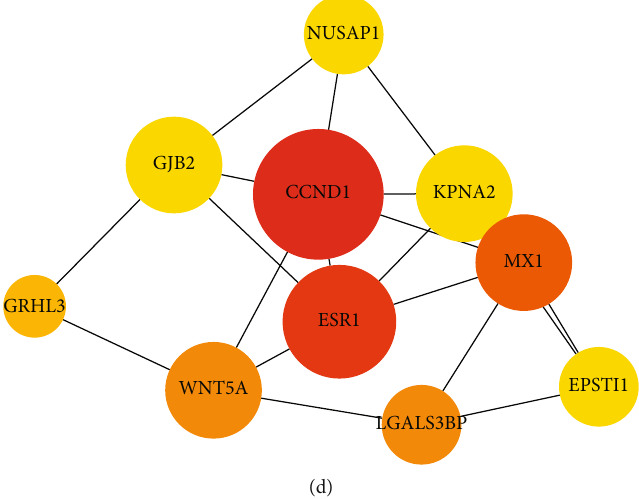
Figure 4: Identi fi cation and analysis of key di ff erentially expressed methylation genes. (a) Venn diagram of hyperdownregulated genes identi fi cation. (b) Venn diagram of hypoupregulated genes identi fi cation. (c) A PPI network for 30 di ff erentially expressed methylated genes. (C) Identi fi cation of 10 key